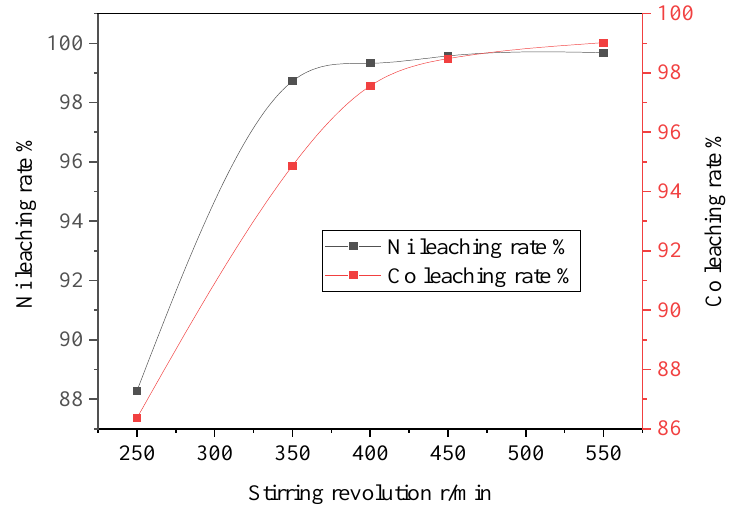
Figure 4. Effect of stirring speed on the leaching rates of Ni and Co.